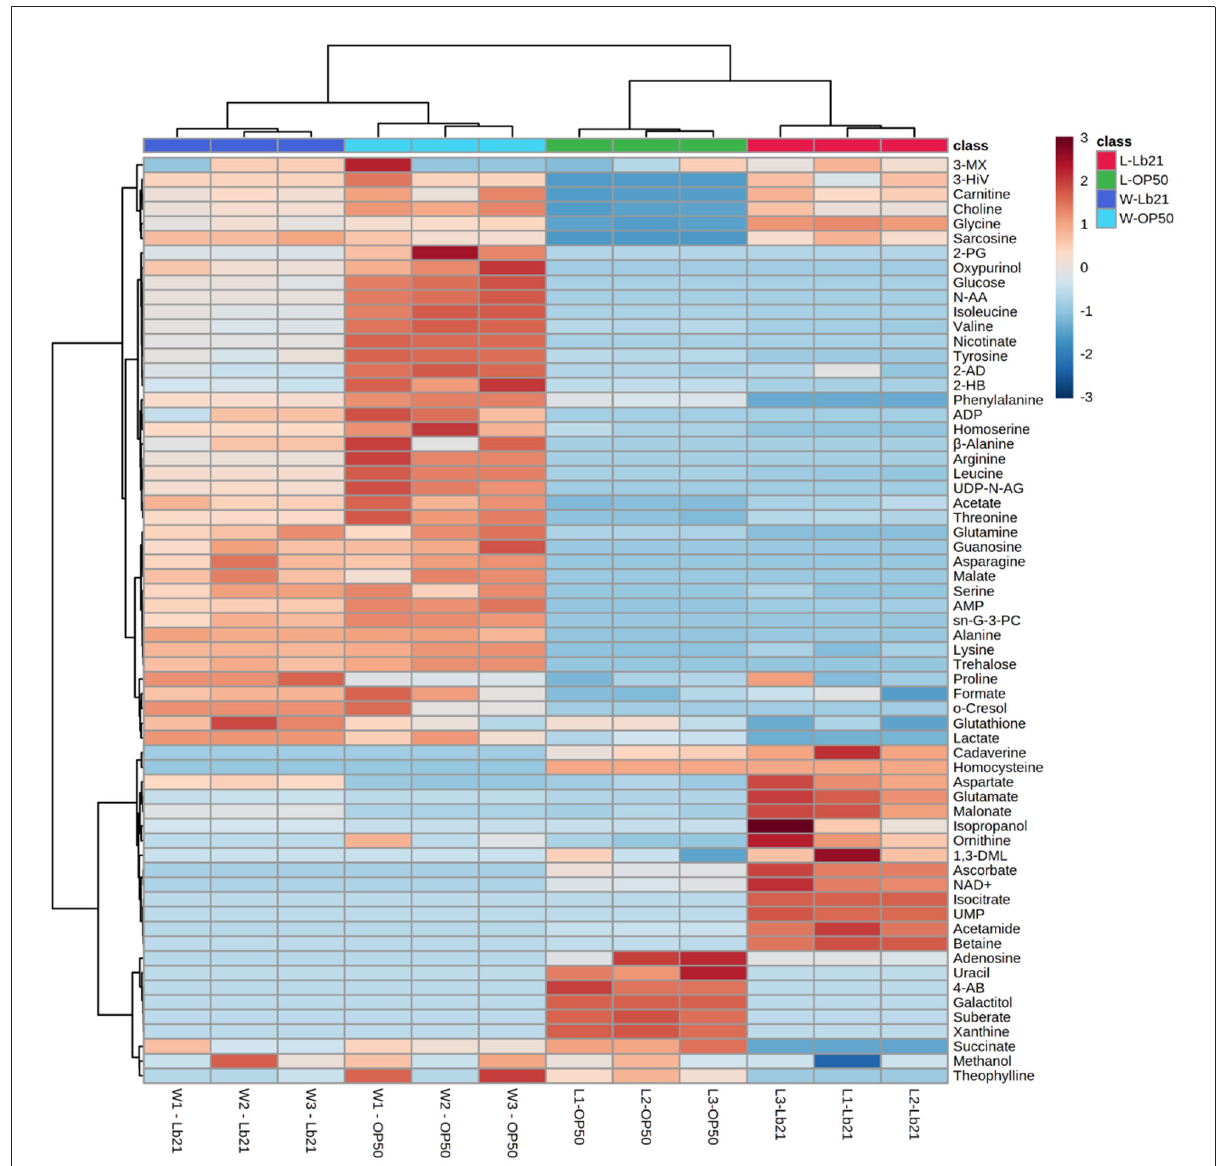
FIGURE2 Host metabolic profiles do not simply reflect the metabolic profile of the bacterial diets: Heat map representing the hierarchical clustering of all the assigned metabolites in four different sample groups, each made in triplicate. Bacterial lawn samples are shown to the right (L-OP50 and L-Lb21) and worms samples to the left (W-OP50 and W-Lb21). Each row shows data for a specific metabolite, and each column shows data for bacteria and worms. Red and blue denote relatively high and low levels, respectively, compared to the average